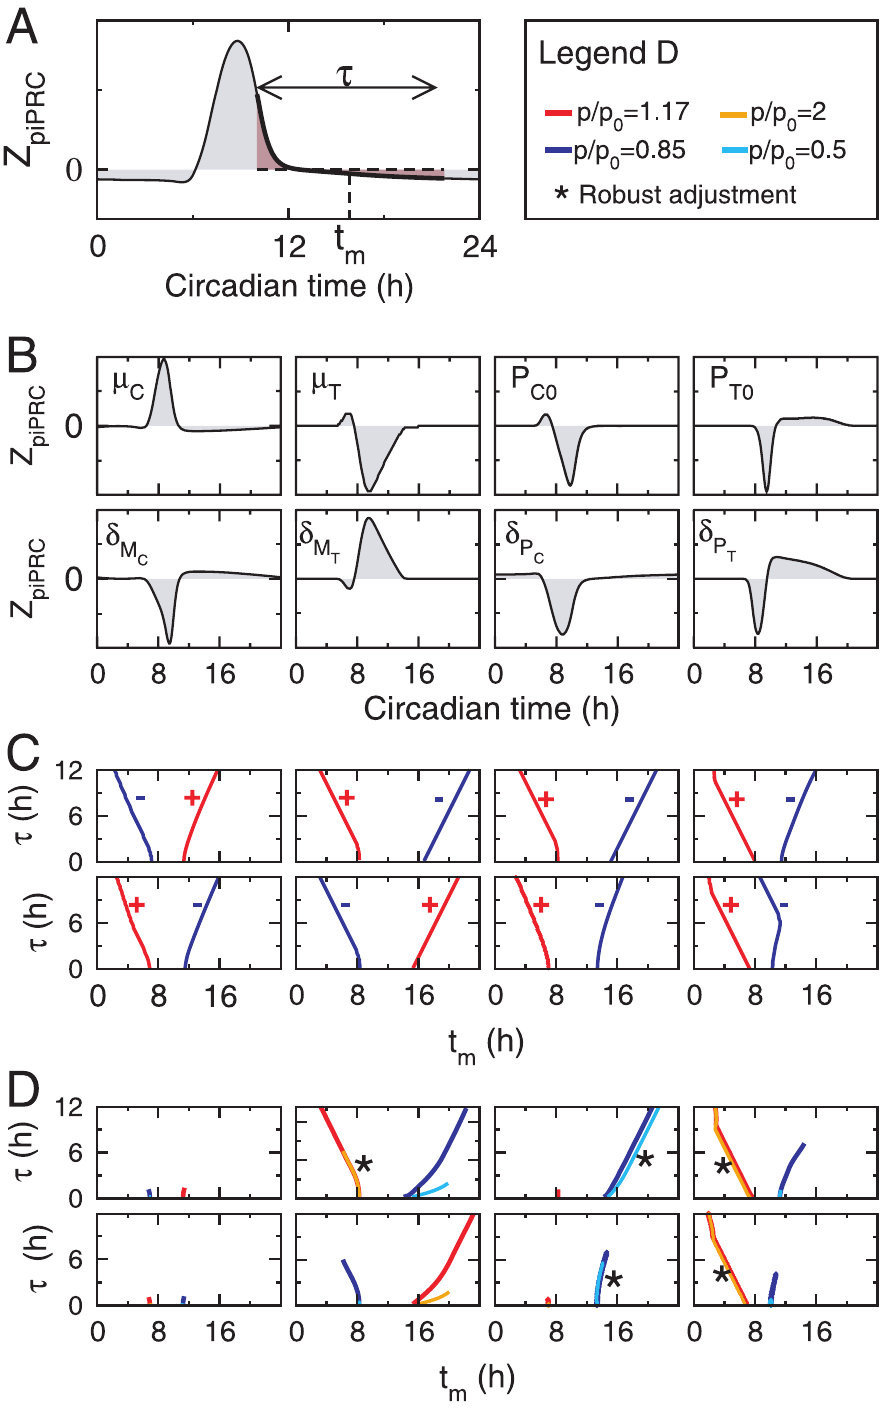
Figure 5. Characterization of coupling schemes. (A) Schematic representation of how window center and duration t m and t , which characterize a coupling with rectangular gating profile, are estimated from the piPRC using Eq. (1). (B) piPRC characterizing the phase change induced by an infinitesimal perturbation of some parameters of the model (transcription an degradation kinetics). (C) Characterization of window center t m and duration t satisfying Eq. (1) for the coupling mechanisms shown in (B), as illustrated in (A). Parameters chosen in (B) are modulated either positively (red) or negatively (blue). (D) Characterization of window center and duration of gated couplings which adjust experimental data with a RMS error below 10% for two different coupling strengths (see box on the right-hand side of the top: p = p 0 is the ratio between the parameter values within and outside the coupling window).